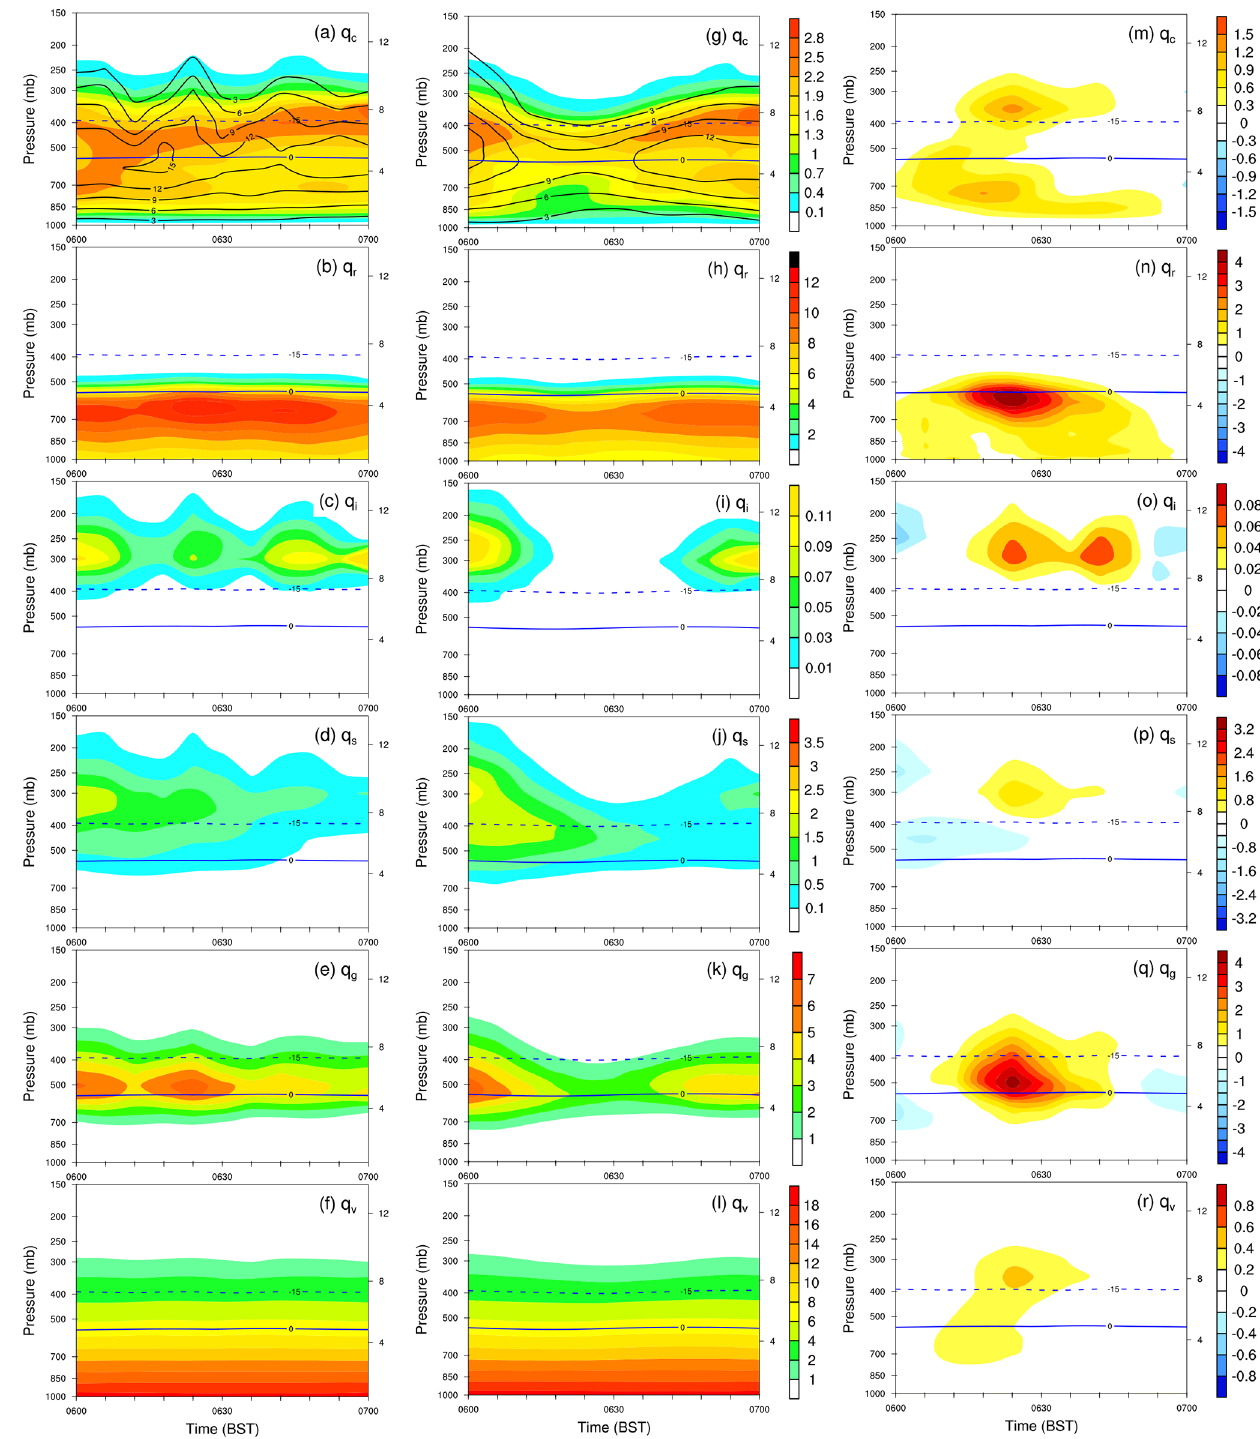
Figure 9. Comparison of time–height cross-sections of domain-averaged mixing ratios between the EN scheme (a–f) and the BR scheme (g–i) during the period from 06:00 to 07:00BST 7 May 2017 within the domains marked with pink lines in Fig. 6; q c , q r , q i , q s , and q g denote cloud water, rainwater, cloud ice, snow, and graupel, respectively. Panels (m) – (r) give the differences between EN and BR (i.e, EN − BR). Thick blue lines indicate an isotherm of − 15 and 0 ◦ C, respectively.